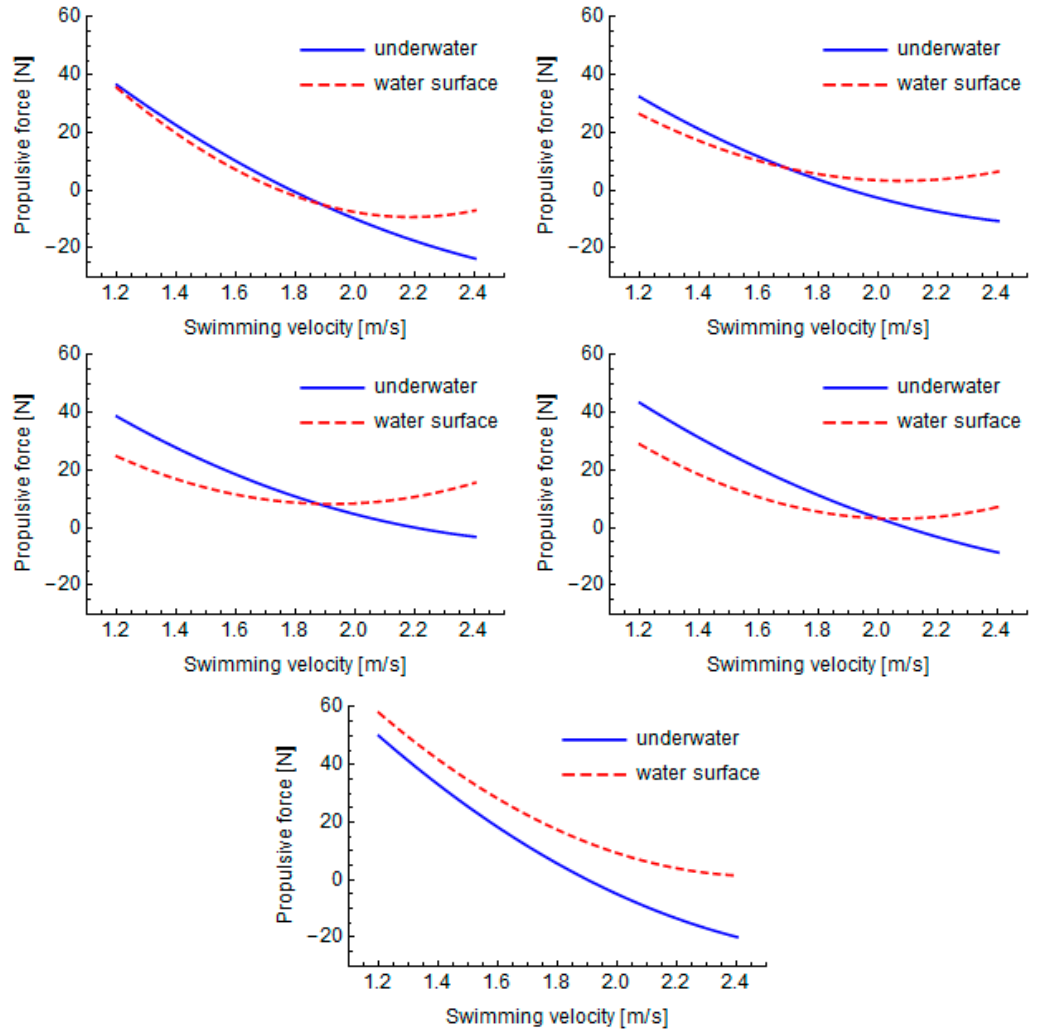
Figure 5. Comparison of the estimated propulsive force between the water surface and 0.60 m depth conditions in each